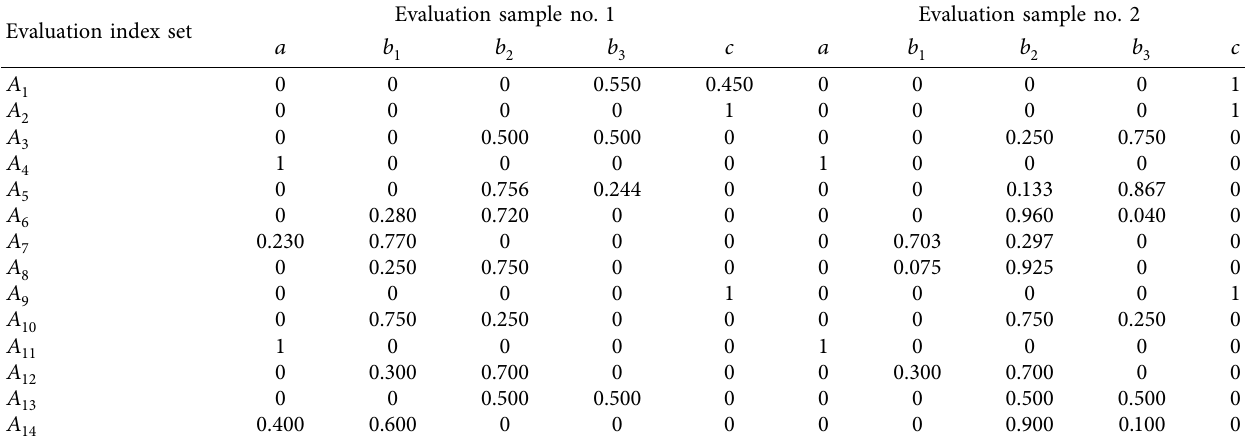
Table 6: Single-index connection degree of evaluation sample nos. 1 and